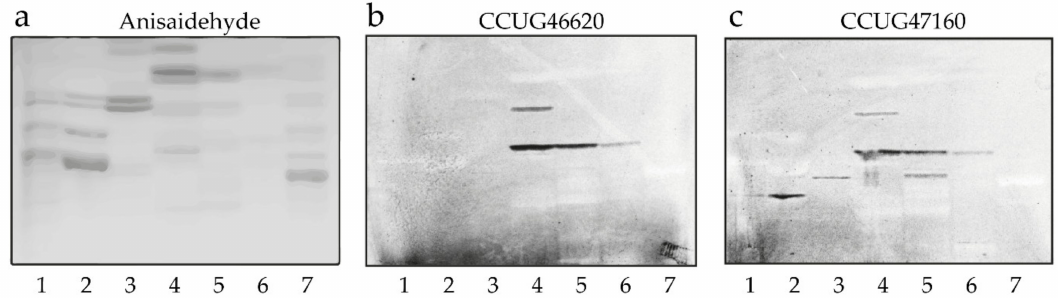
Figure 5. Screening for C. matruchotii carbohydrate recognition by binding to glycolipids on thin-layer chromatograms. ( a ) Chemical detection by anisaldehyde. ( b ) Autoradiograms obtained by binding of C. matruchotii strain CCUG46620 and ( c ) C. matruchotii strain CCUG47160, followed by autoradiography for 12 h. The solvent system used was chloroform / methanol / water (60:35:8, by volume). Lane 1, non-acid glycosphingolipids of human blood group AB erythrocytes, 40 µ g; lane 2, non-acid glycosphingolipids